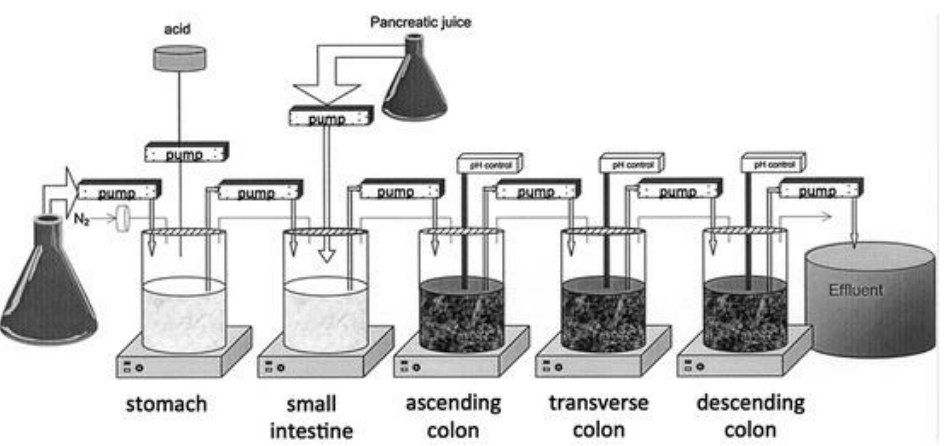
Figure 11. Schematic overview of SHIME ® . Adopted from [4], SpringerLink,